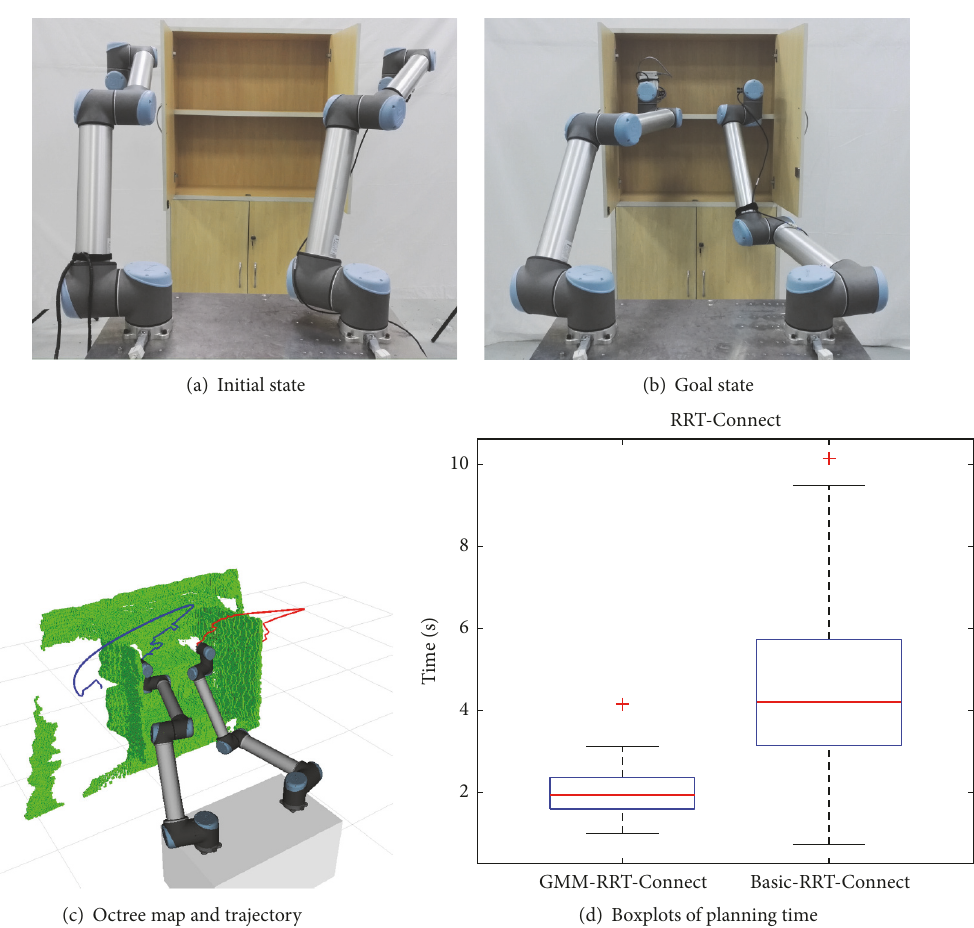
Figure 11: 12-DOF dual-arm robot experiment.(a), (b) The initial and goal state of the planning problem, respectively. (c) The environmental model represented by octree, and the lines represent the trajectory of end effectors. (d) The boxplots of planning time based on GMM and basic collision query